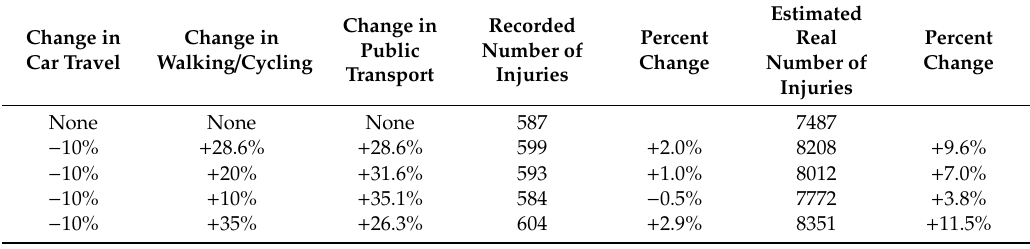
Table 4. Estimated changes in the number of injured road users in Oslo associated with more walking, cycling or travel by public transport.